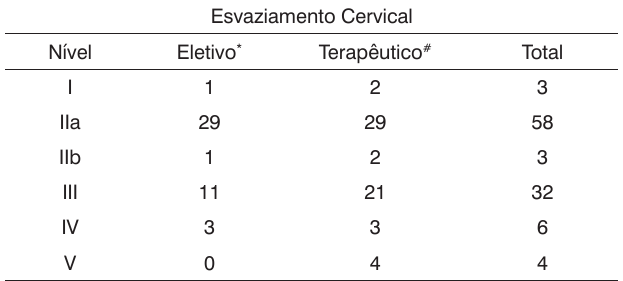
Tabela 1. Níveis linfonodais acometidos conforme o tipo de esvaziamento cervical